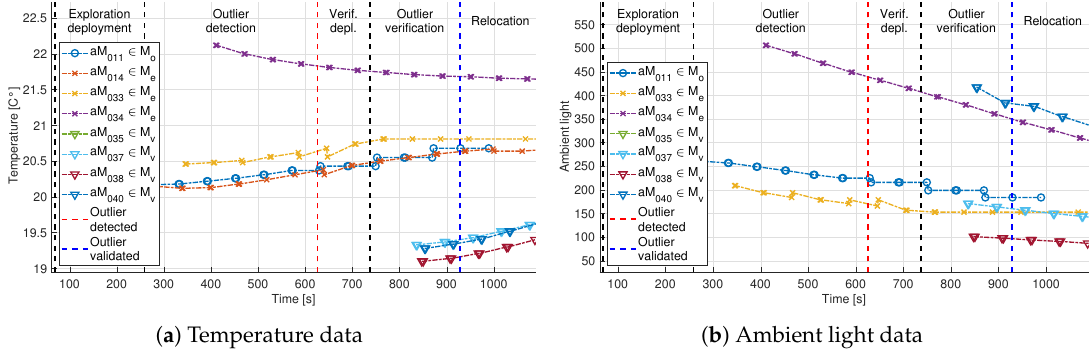
Figure 20. Additional sensor data exchanged via acoustic communication during the Biograd na Moru